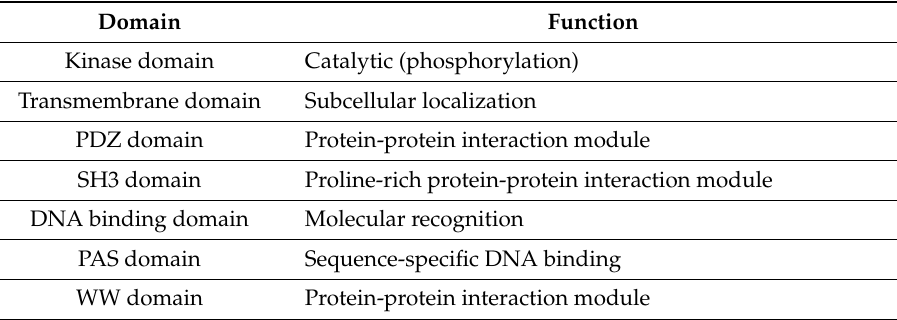
Table 8. Highly cited protein domain search terms in the PubMed